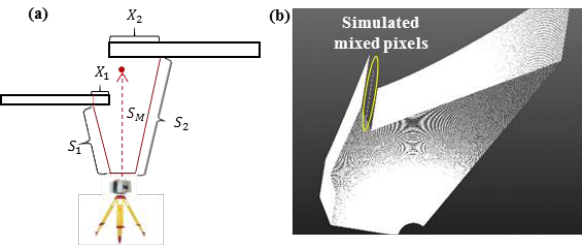
Figure 2. a) Schematic representation of the mixed pixel phenomena; b) simulated point clouds of the planar